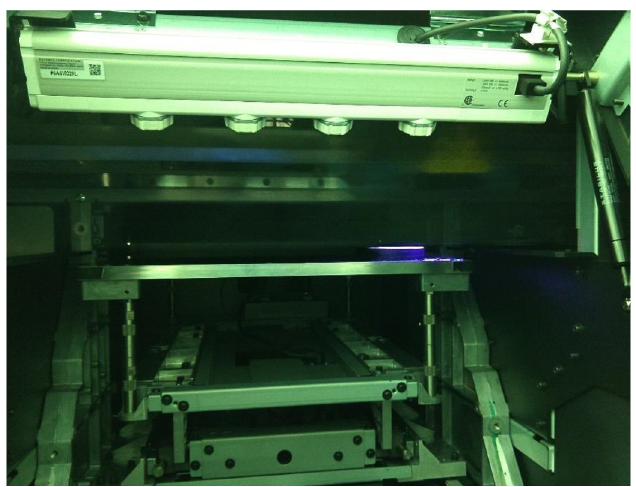
Figure 3. Inkjet Printing process of the treated/non-treated parts.